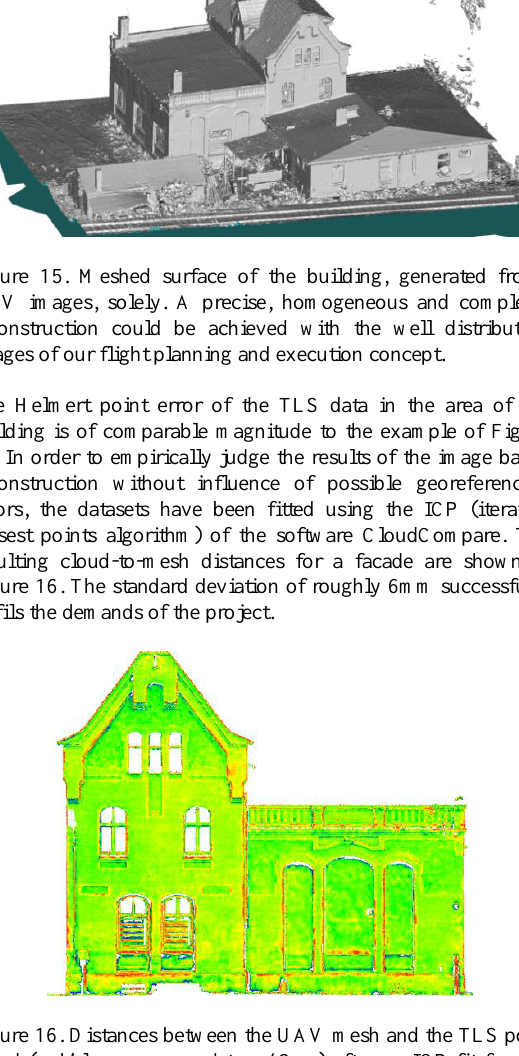
Figure 16. Distances between the UAV mesh and the TLS point cloud (red/blue correspond to +/-2cm) after an ICP fit for one facade. The achieved standard deviation is